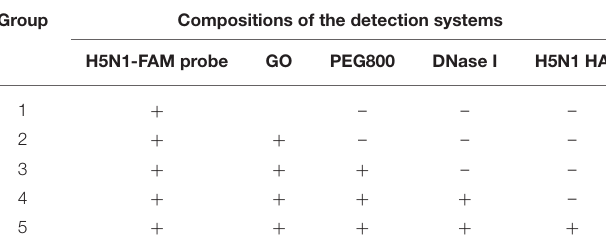
TABLE 1 | Composition of the detection systems in different groups.